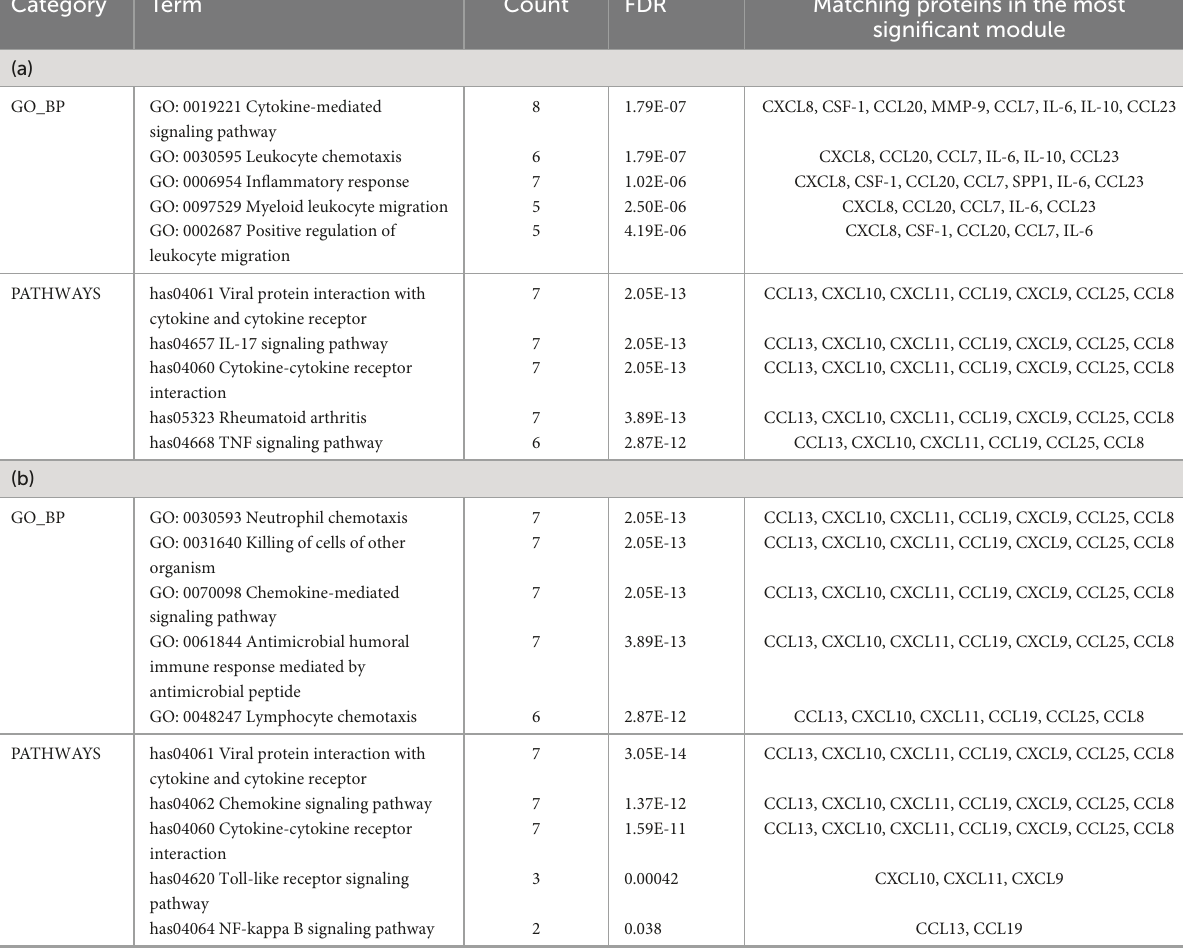
TABLE 3 GO_BP and KEGG pathways enriched in the most significant module in the CB group (only top five listed). Category Term Count FDR Matching proteins in the most